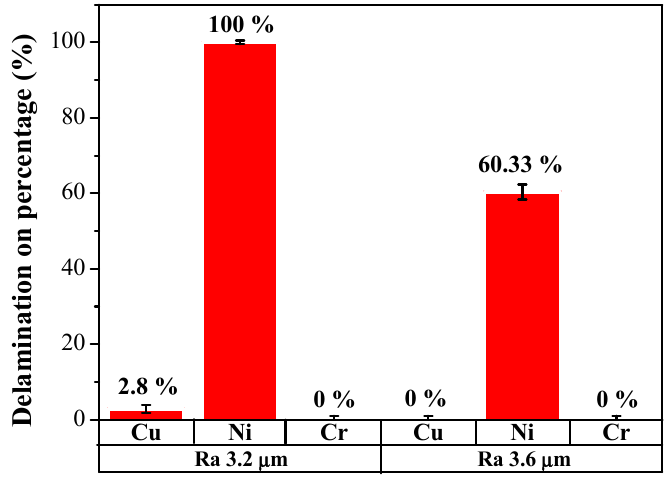
Figure 18. The effect of different metals and roughnesses on delamination. Figure 18. The e ff ect of di ff erent metals and roughnesses on